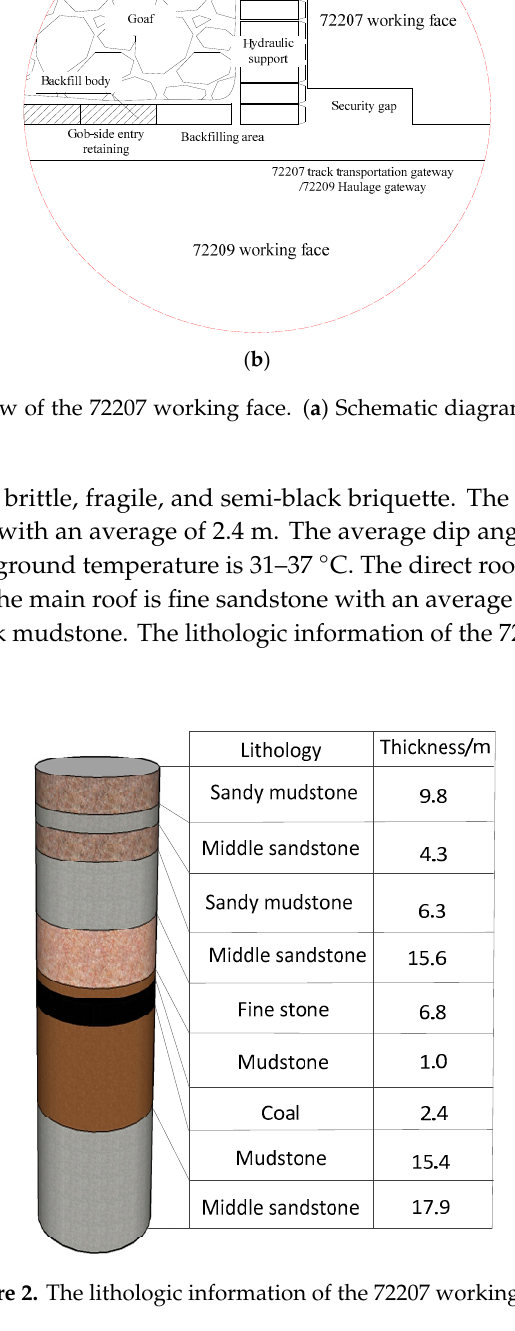
Figure 2. The lithologic information of the 72207 working face. Table 1. Experimental parameters of rock and rock mechanics.